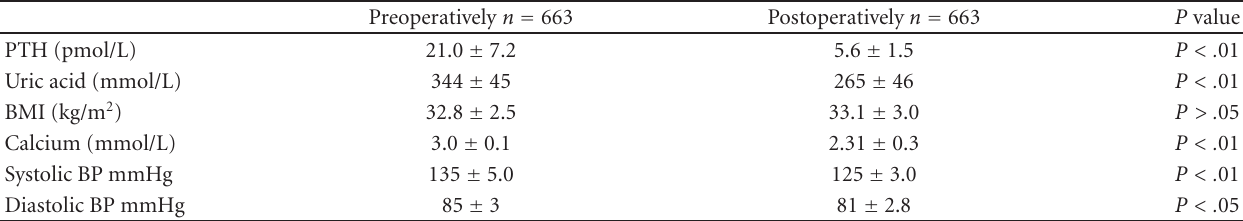
Table 3: Preoperative and post-operative biochemical data, BMI and arterial blood pressure in hypertensive patients with primary hyperparathyroidism on antihypertensive medication. Results are presented as mean values ± SD.